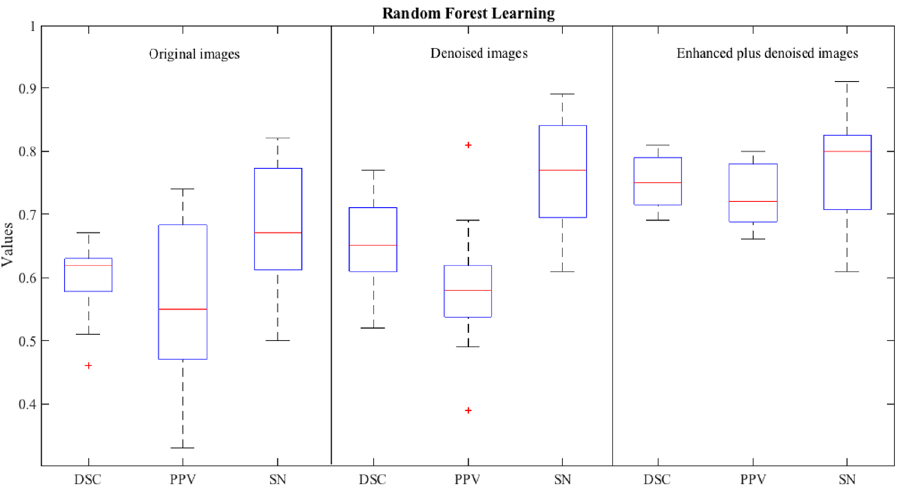
Figure 9. Segmentation accuracies of the random forest learning based method for the original 7 T MR images (left), denoised images (middle), and our enhanced and denoised images